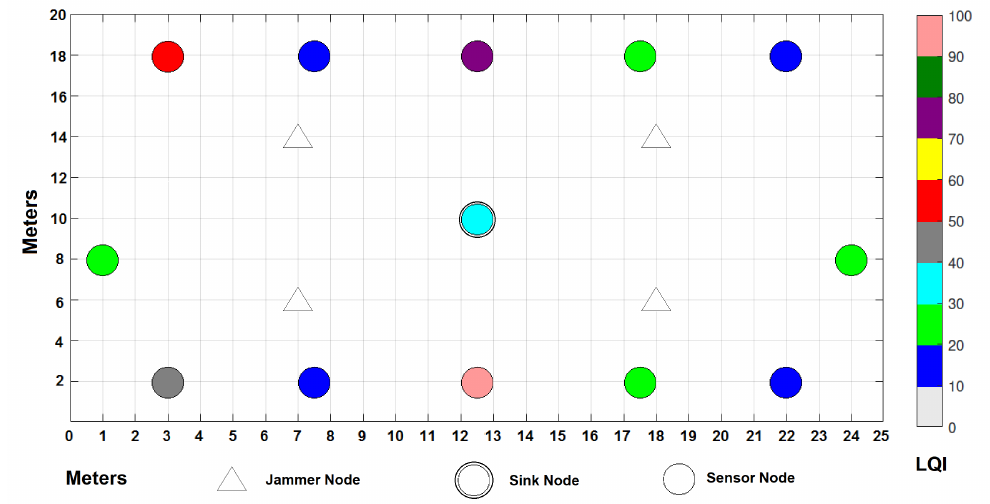
Figure 16. LQI results per node under a cooperative scheme.